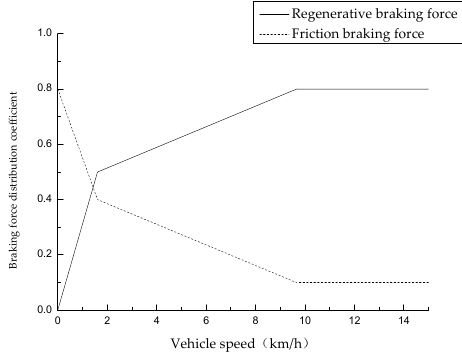
Figure 6. Brake force distribution map based on vehicle speed.